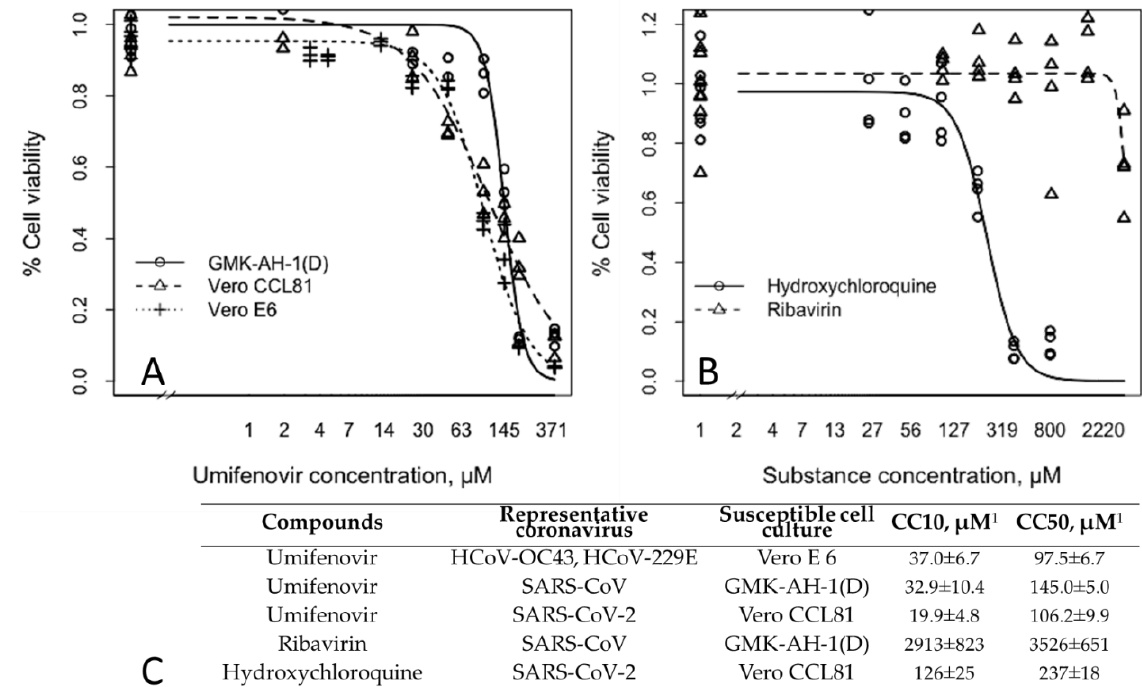
Figure 1. Cytotoxicity of antivirals in different cell lines. Vero E6, GMK-AH-1(D), and Vero CCL81 cells were seeded into 96-well microtiter plates and incubated until formation of a confluent monolayer. Umifenovir ( A ), ribavirin, and hydroxychloroquine ( B ) were added at various concentrations. The impact of treatment on cell viability was assessed by MTT assay after 72 h incubation. CC10 and CC50 values were generated and represented as mean ± SD ( C ). The three-parameter log-logistic (LL.3) function was used. 1 CC10 and CC50 were determined from three independent